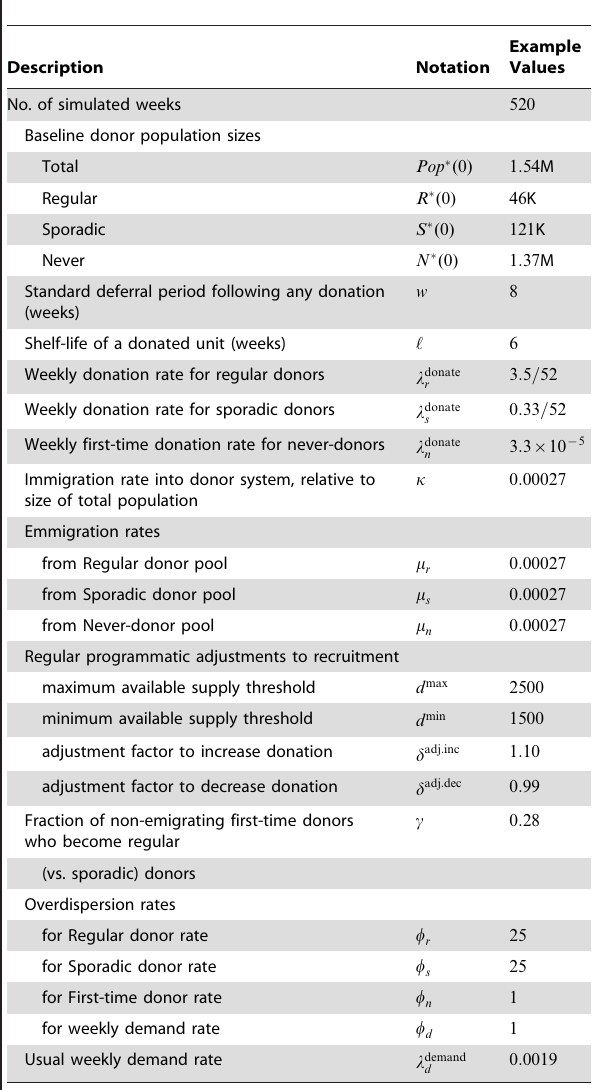
Table 1. Input Parameters for a ‘‘Normal’’ Period (informed by expert opinion or data).